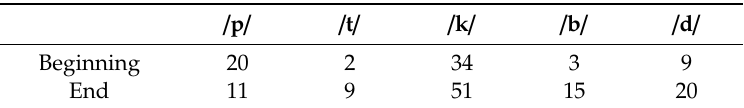
Table A7. Token counts for consonant measurements used to assess changes in production of voiceless and voiced consonants by Informant C in Sections 4.1.1 and